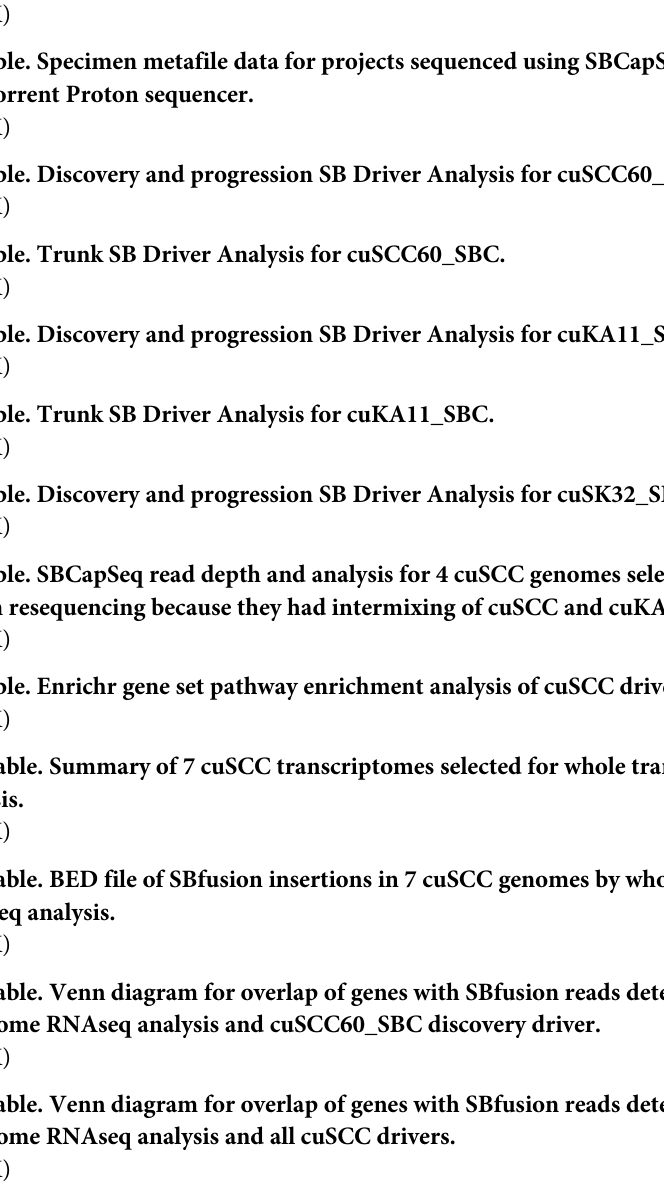
S1 Table. Tumor incidence and subgroup classifications by cohort. S2 Table. Specimen metafile data for projects sequenced using SBCapSeq protocol with Ion Torrent Proton sequencer. S3 Table. Discovery and progression SB Driver Analysis for cuSCC60_SBC. S4 Table. Trunk SB Driver Analysis for cuSCC60_SBC. S5 Table. Discovery and progression SB Driver Analysis for cuKA11_SBC. S6 Table. Trunk SB Driver Analysis for cuKA11_SBC. S7 Table. Discovery and progression SB Driver Analysis for cuSK32_SBC. (XLSX) S8 Table. SBCapSeq read depth and analysis for 4 cuSCC genomes selected for multi- region resequencing because they had intermixing of cuSCC and cuKA histologies. (XLSX) S9 Table. Enrichr gene set pathway enrichment analysis of cuSCC drivers. (XLSX) S10 Table. Summary of 7 cuSCC transcriptomes selected for whole transcriptome RNAseq analysis. S11 Table. BED file of SBfusion insertions in 7 cuSCC genomes by whole transcriptome RNAseq analysis. S12 Table. Venn diagram for overlap of genes with SBfusion reads detected by whole tran- scriptome RNAseq analysis and cuSCC60_SBC discovery driver. S13 Table. Venn diagram for overlap of genes with SBfusion reads detected by whole tran- scriptome RNAseq analysis and all cuSCC